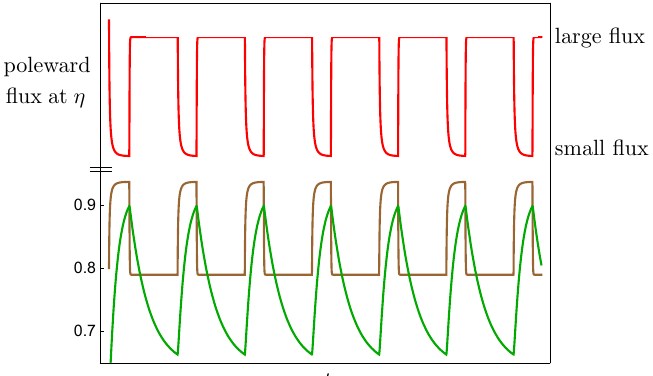
Figure 8. Red : The meridional transport flux (watts) at the albedo line η during the limit cycle pictured in Figure 6a. The flux function has been scaled and translated for this plot. Brown : η . Green : ξ .